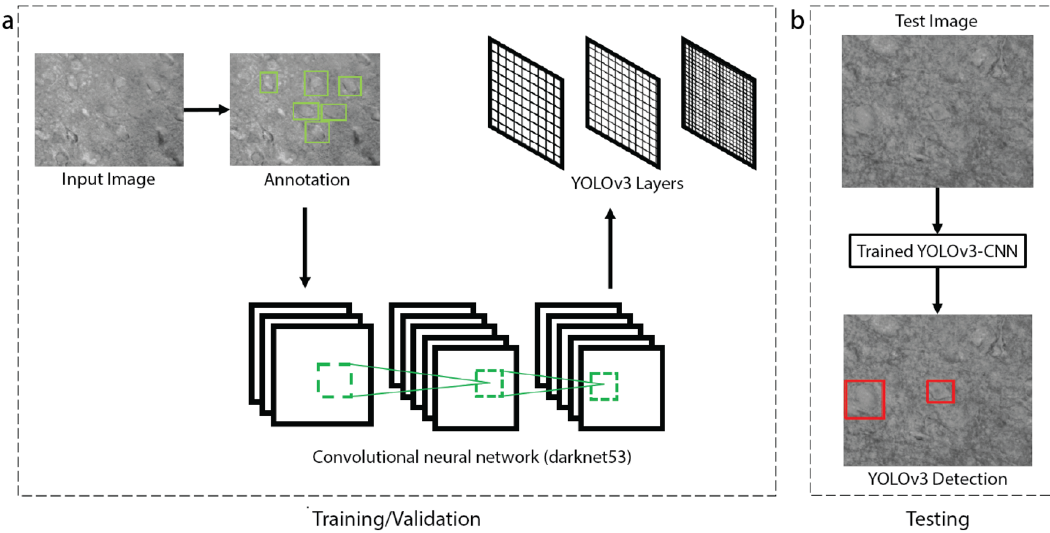
Figure 1. After initial ( a ) training and validation using annotated input images, testing ( b ) shows a successful detection of neurons in unannotated, unaltered